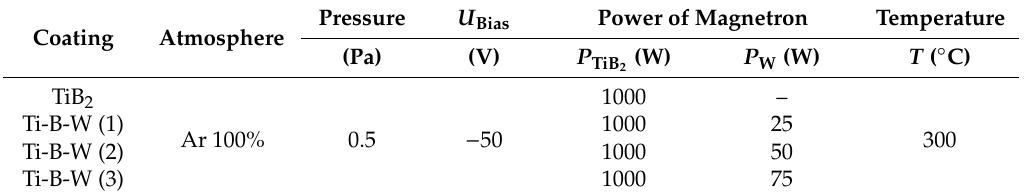
Table 1. Deposition parameters of reference TiB 2 coating and TiB 2 coatings doped with